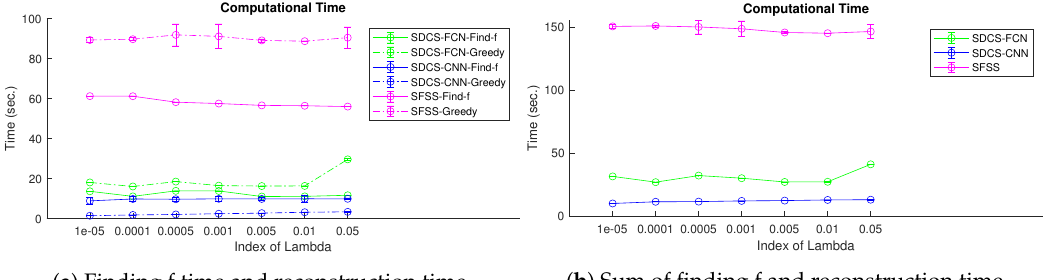
Figure 16. Computational time of three